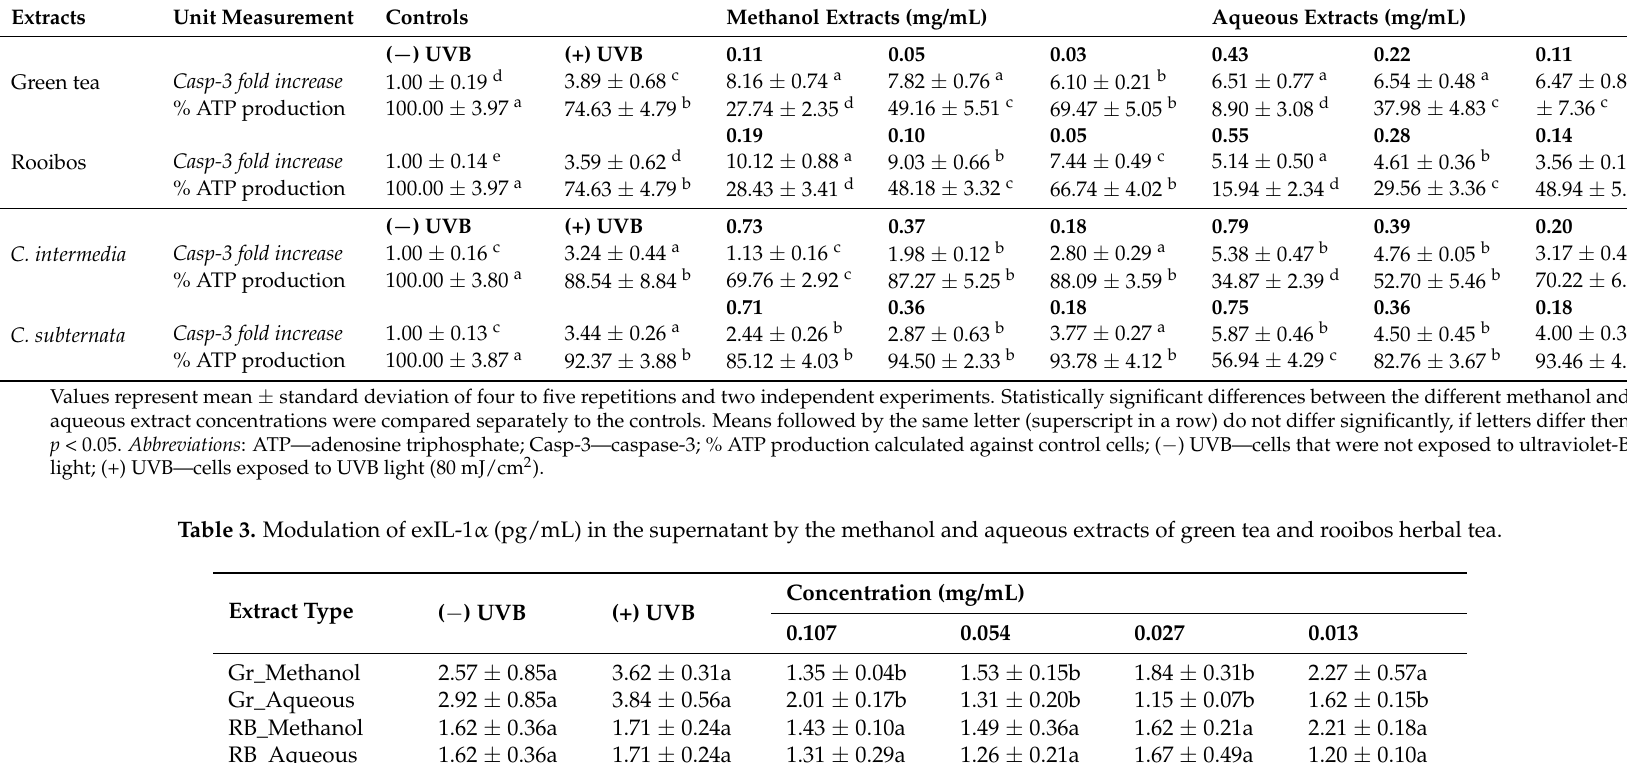
Table 2. Modulation of UVB-induced apoptosis and cell viability (ATP production) by methanol and aqueous extracts of green tea and different herbal teas. Extracts